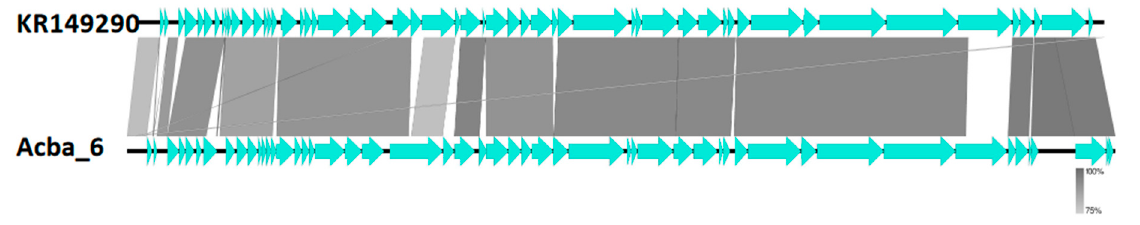
Figure 6. Comparison of genomes between researched phage Acba_6 and a reference phage from Friunavirus genus. Genomes were compared using blastn and represented by the Easyfig software. Horizontal black lines (genome) with blue arrows (ORFs) represent phage genomes. Gray, thick, vertical lines represent similar fragments of genomes between phages. Thin gray or white lines represent similarity between short, internal repeats found in compared genomes.